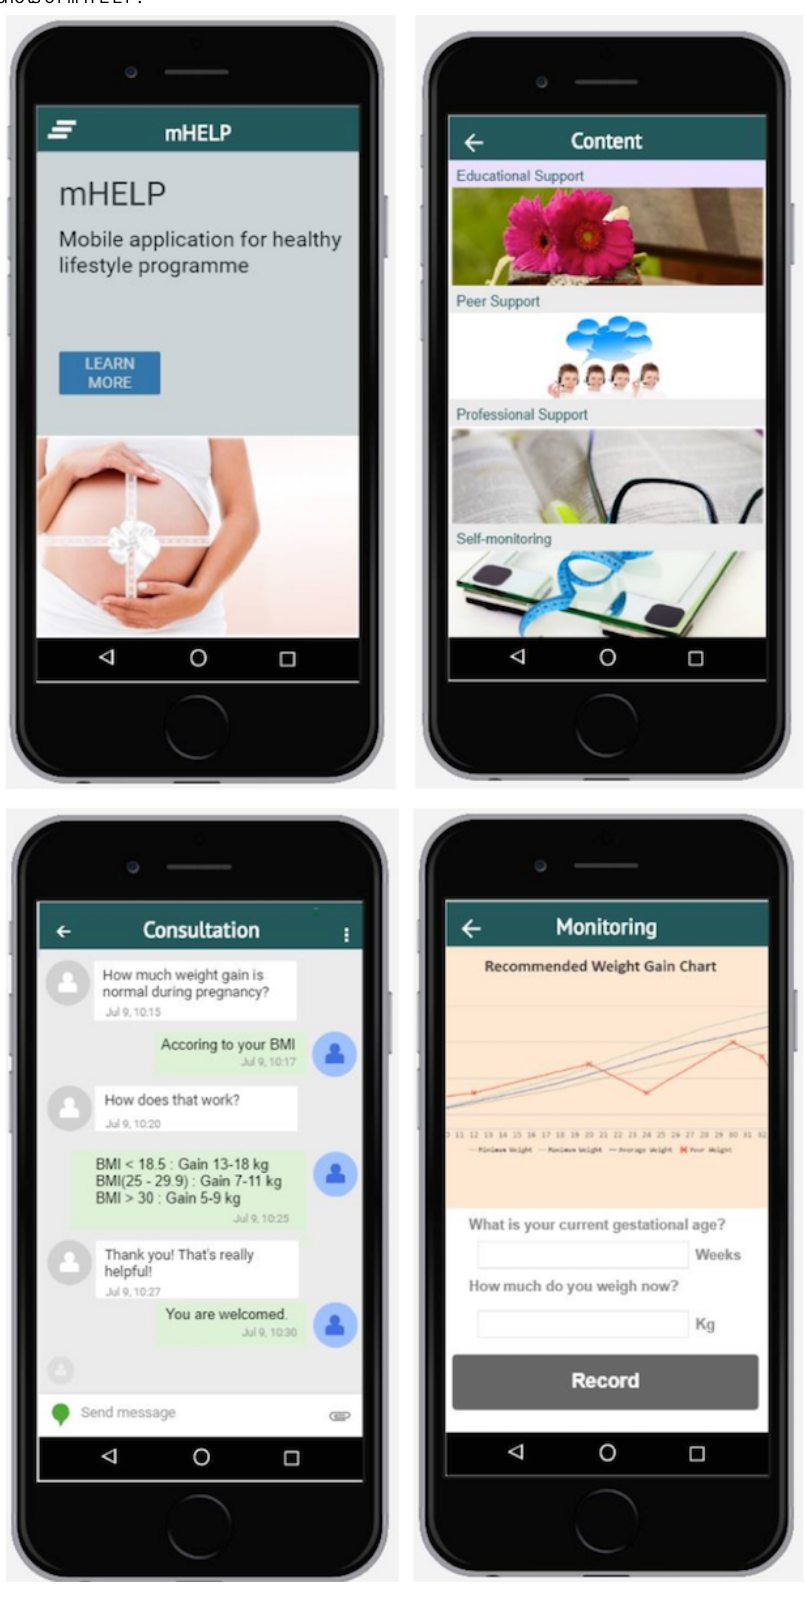
Figure 3. Mock-up screenshots of